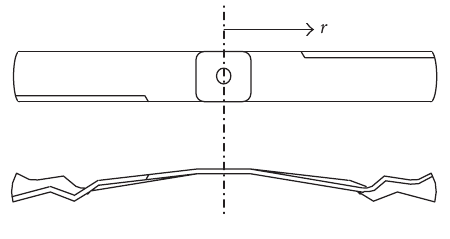
Figure 5: Schematic diagram of tested blade.